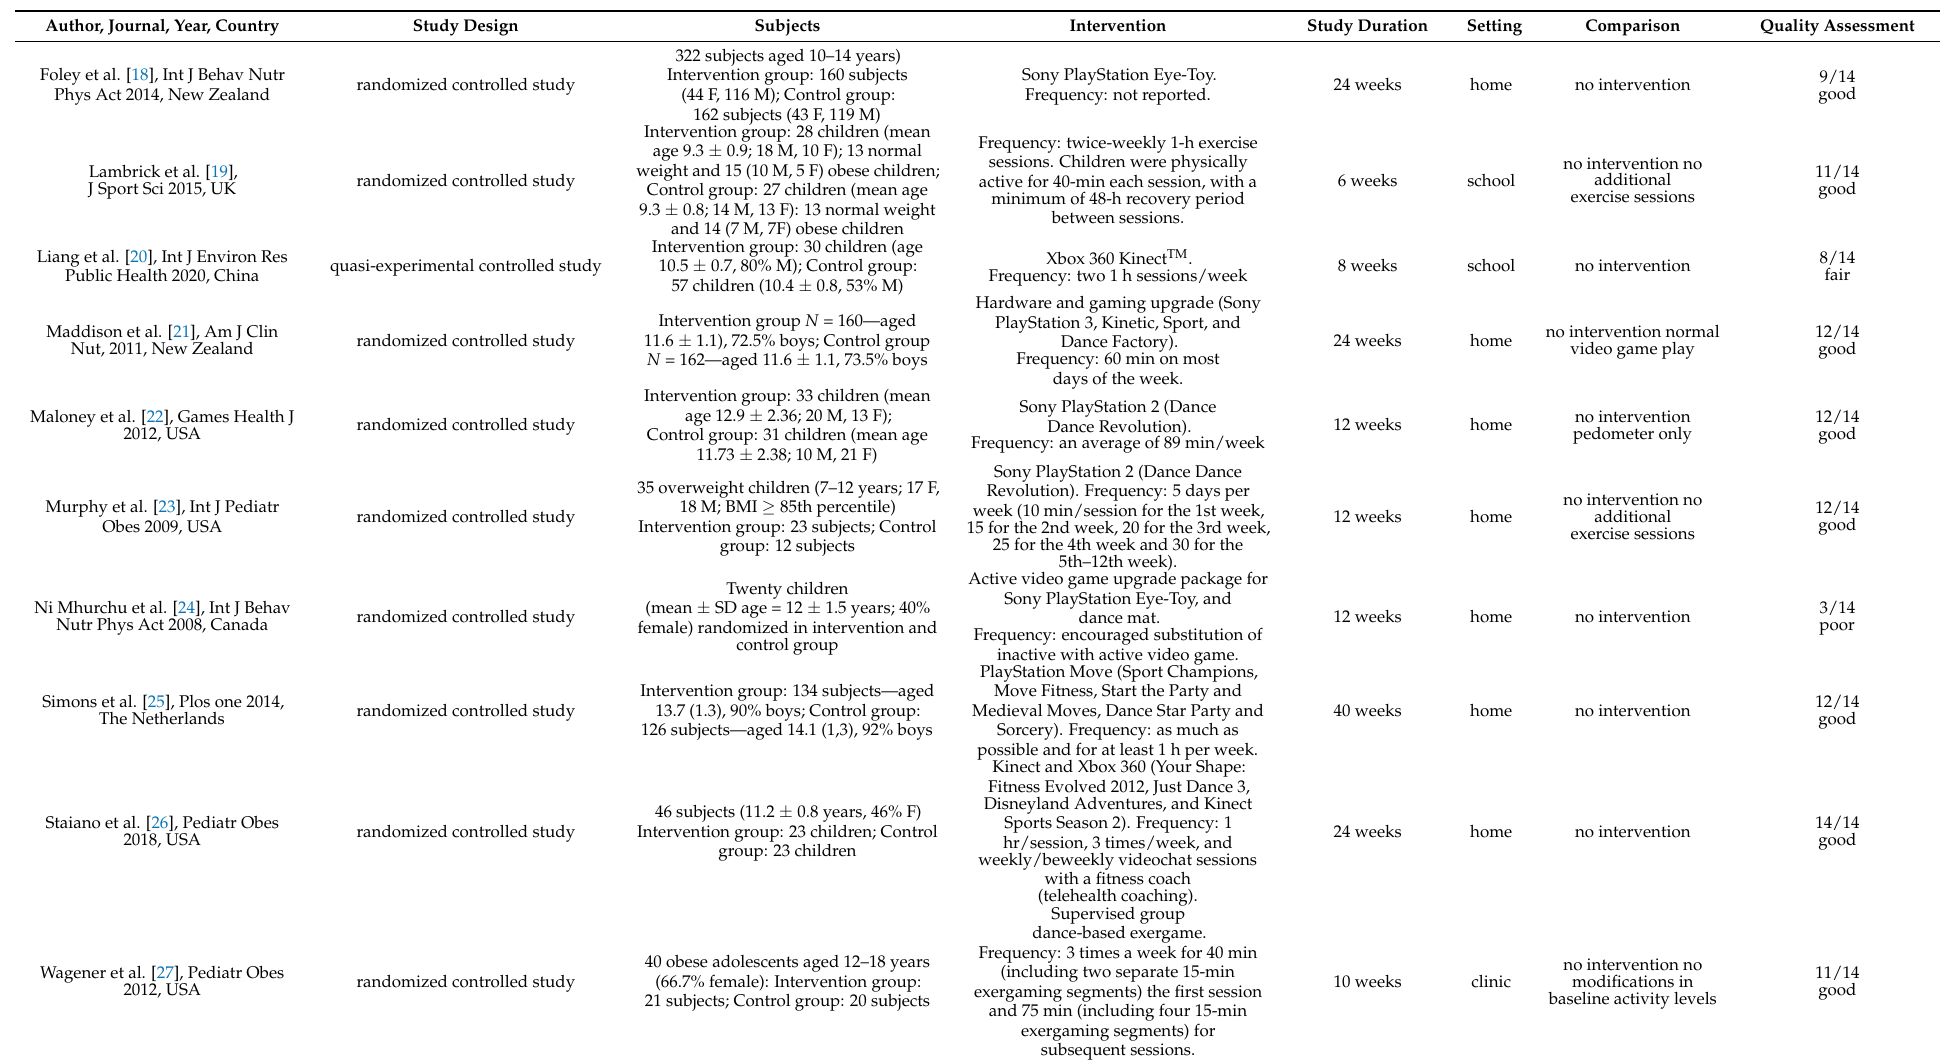
Table 1. Main characteristics of the selected